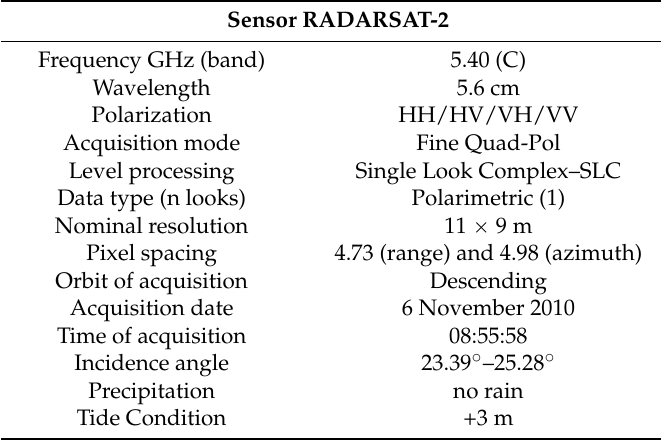
Table 1. Characteristics of the SAR image and environmental conditions on the acquisition day.